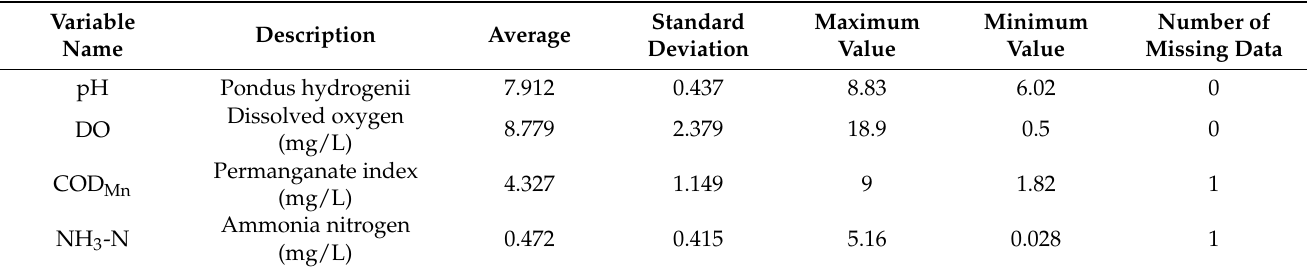
Table 1. Statistical descriptions of data series.